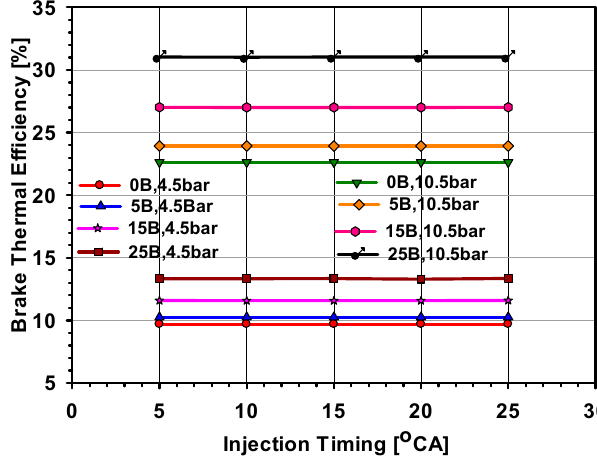
Figure 13. Variation of BTE.